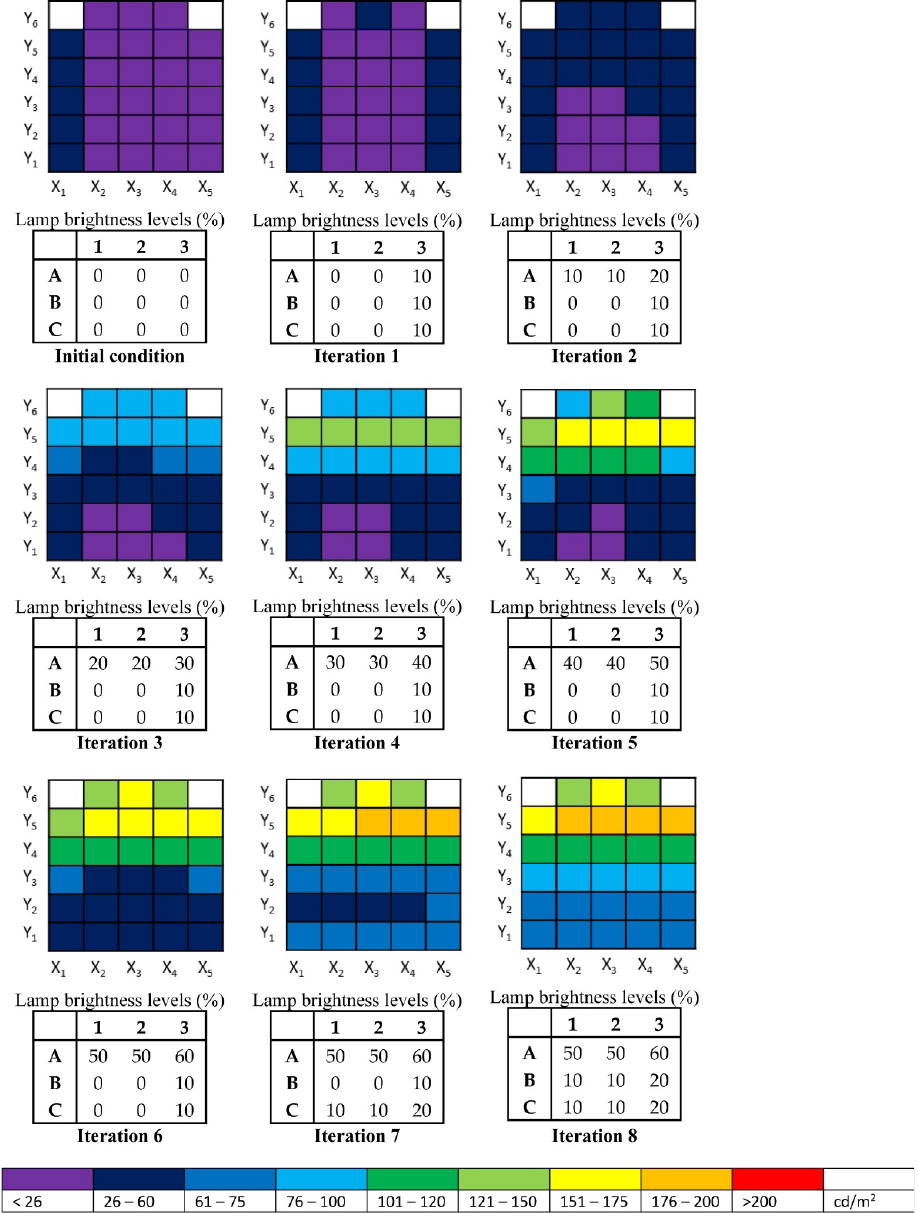
Figure 12. The luminance values and lamp brightness levels for Measurement Scheme 2B.